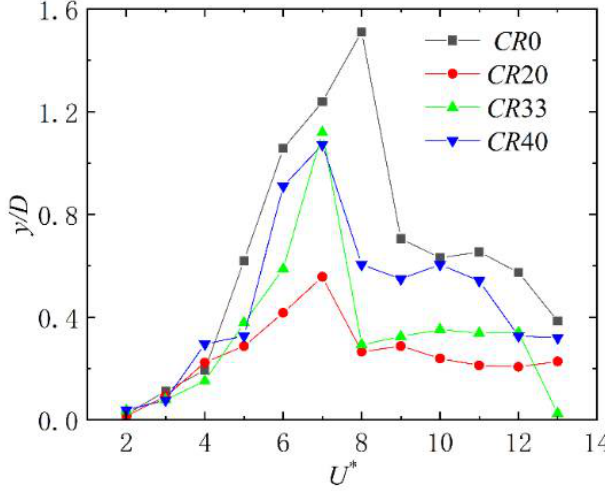
Figure 14. Vibration amplitude of a cylinder with surface bulges in transverse direction.